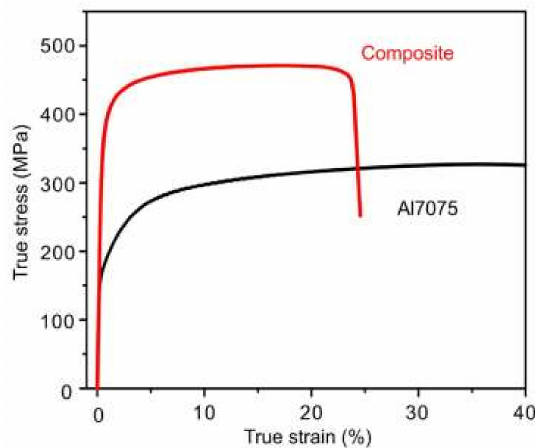
Figure 18. Compressive stress–strain curves of 15% volume fraction Zr based glassy fiber reinforced Al7075 composite made by spark plasma sintering. The behavior is compared with that of the unreinforced Al7075 alloy [43]. (Open Access).